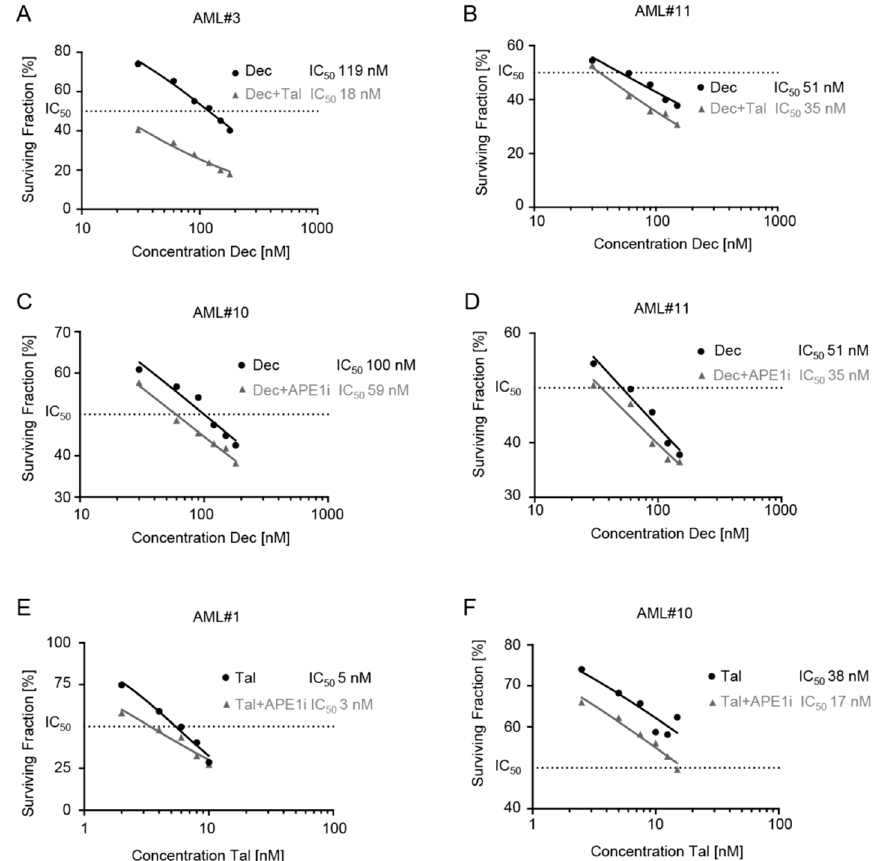
Figure 2. Surviving fractions of CD34+ or CD34 − acute myeloid leukemia (AML) cells after initial expansion for 3 days followed by 3 days of treatment with (I) decitabine ± talazoparib, (II) decitabine ± APE1 inhibitor III, and (III) talazoparib ± APE1 inhibitor III. ( A , B ) Exemplary surviving fractions of AML cells treated with decitabine ± talazoparib. ( C , D ) Exemplary surviving fractions of AML cells treated with decitabine ± APE1 inhibitor III. ( E , F ) Exemplary surviving fractions of AML cells treated with talazoparib ± APE1 inhibitor III.